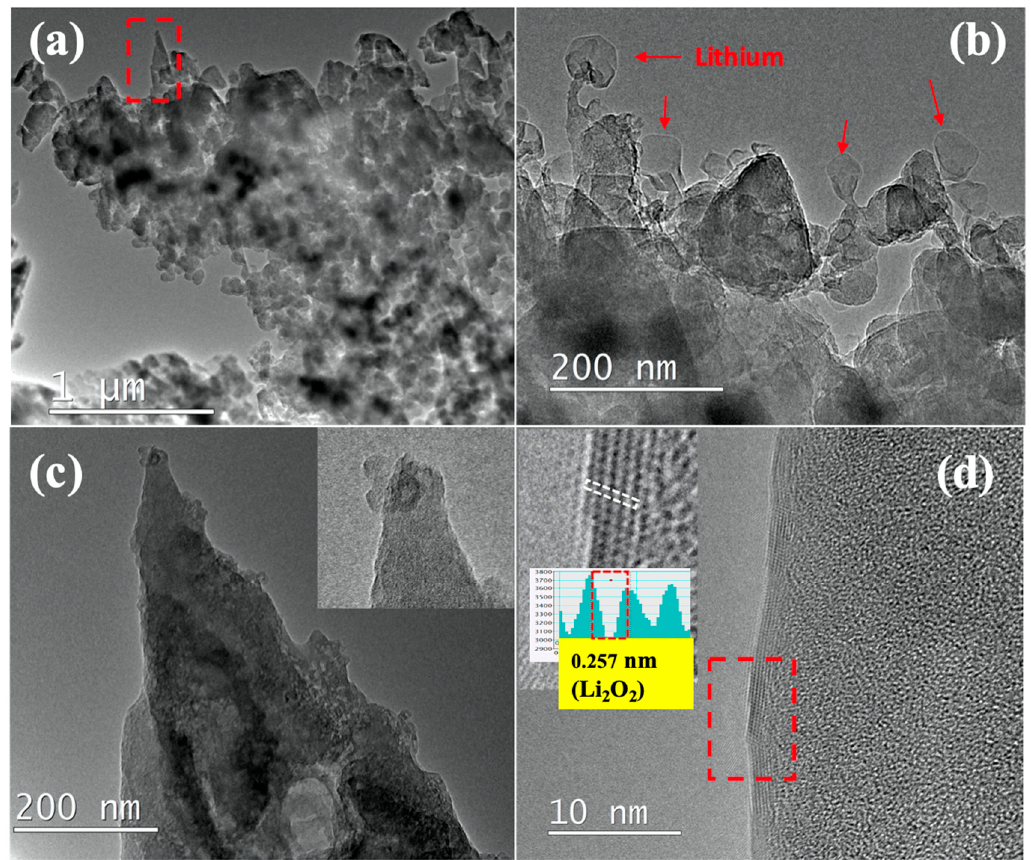
Figure 3. ( a ) Low mag TEM image showing Li-C NC fabricated at 1keV of Ar + . ( b ) Red arrows showing Li balls observed during TEM observation ( c ) Conical Li-C NC synthesized at 1 keV (of the area indicated by the rectangular selection of Figure 3a). ( d ) Edge of the conical Li-C NC showing the presence of the atomic lattice. The inset shows the presence of the Li 2 O 2 lattice in the area indicated by the red rectangle.